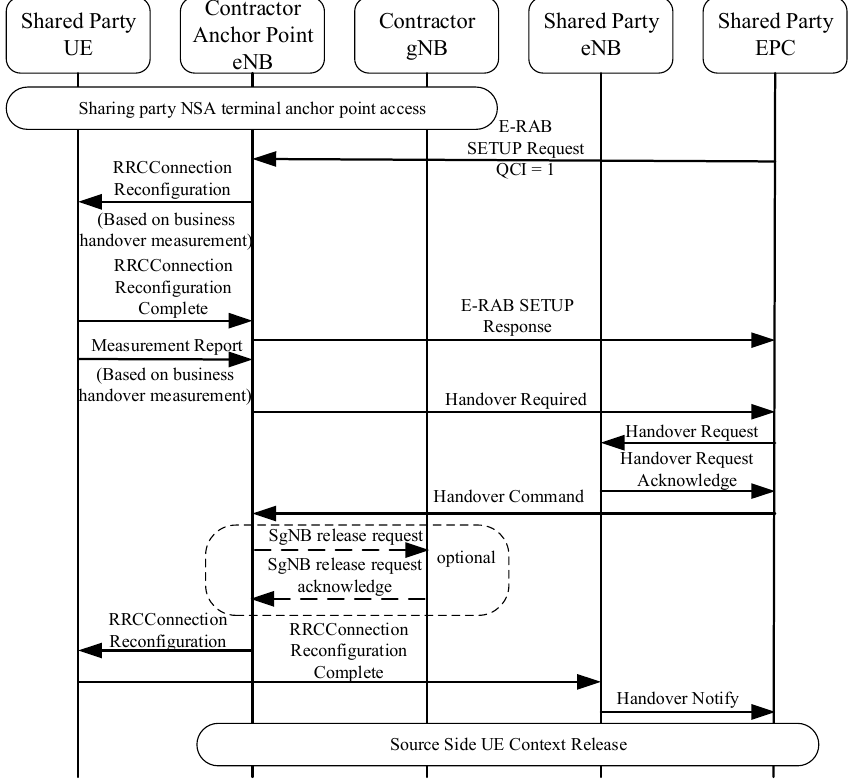
Figure 4. Service-based inter-frequency handover process for voice over LTE (VoLTE).